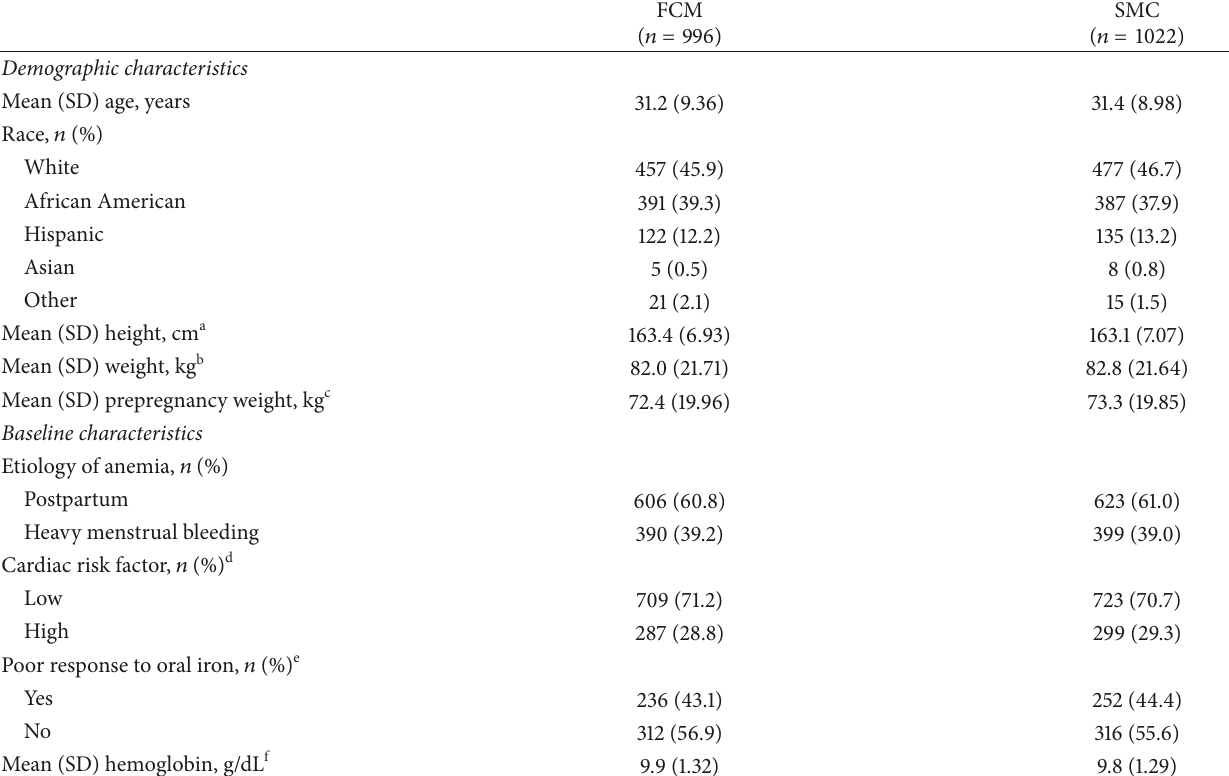
Table 1: Demographic and baseline characteristics (safety